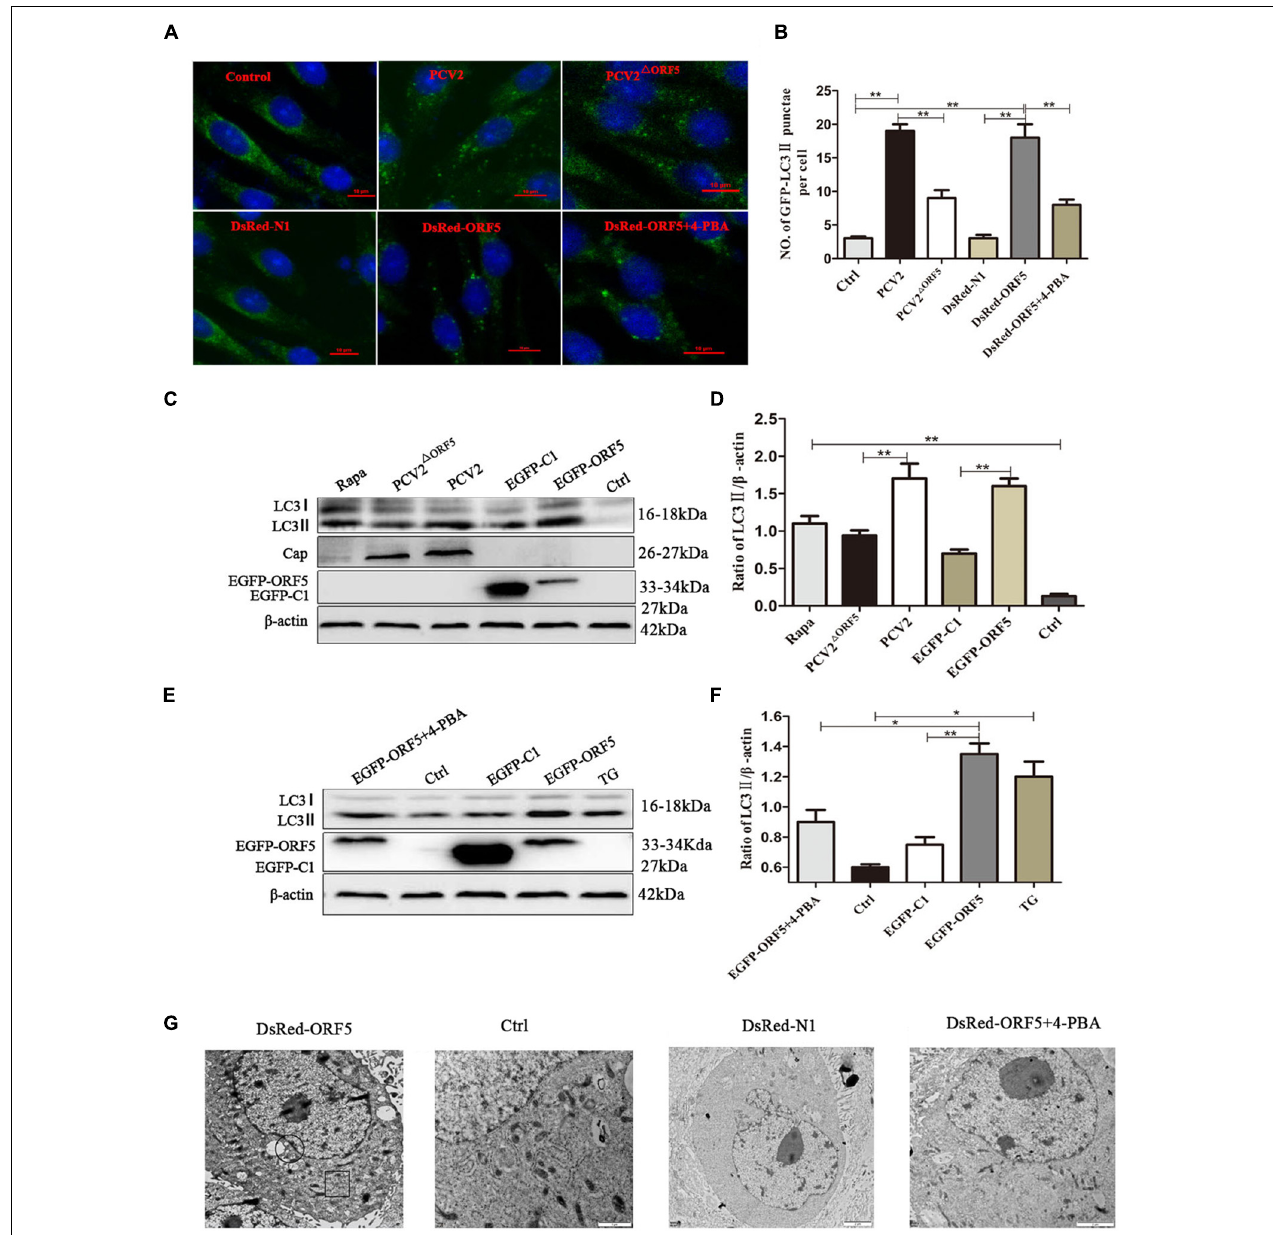
FIGURE 1 | ORF5 induces autophagy in PK-15 cells. (A) Formation of autophagosomes, shown as green punctate in PK-15 cells that were analyzed by fluorescence microscopy (scale bar, 10 µ m). (B) Statistical analysis of panel (A) , the number of GFP-LC3 points per cell. (C) PCV2 and PCV2 (cid:49) ORF5 were infected with PK-15 cells, and EGFP-ORF5 was transfected into PK-15 cells. All samples were collected 36 h post-infection or post-transfection. (D) Perform a T -test on the grayscale analysis of the (C) , the ratio of LC3 to β -actin. (E) PK-15 cells were pretreated with 4-PBA for 2 h and then transfected with EGFP-ORF5. At 36 h post- transfection, immunoblotting was performed. (F) Perform a T -test on the grayscale analysis of the (E) , the ratio of LC3 to β -actin. (G) Electron microscopy of autophagosomes and endoplasmic reticulum after transfection of DsRed-ORF5 plasmids. The black box indicates the autophagosome. The scale bar in DsRed-ORF5 panel is 10 µ m. In the rest panels is 2 µ m. The endoplasmic reticulum structure in the black circle is swollen and rounded. * p < 0.05, ** p <